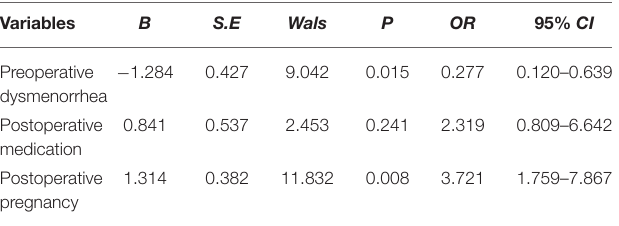
TABLE 3 | Multi-factor analysis of postoperative recurrence in patients with endometriosis.